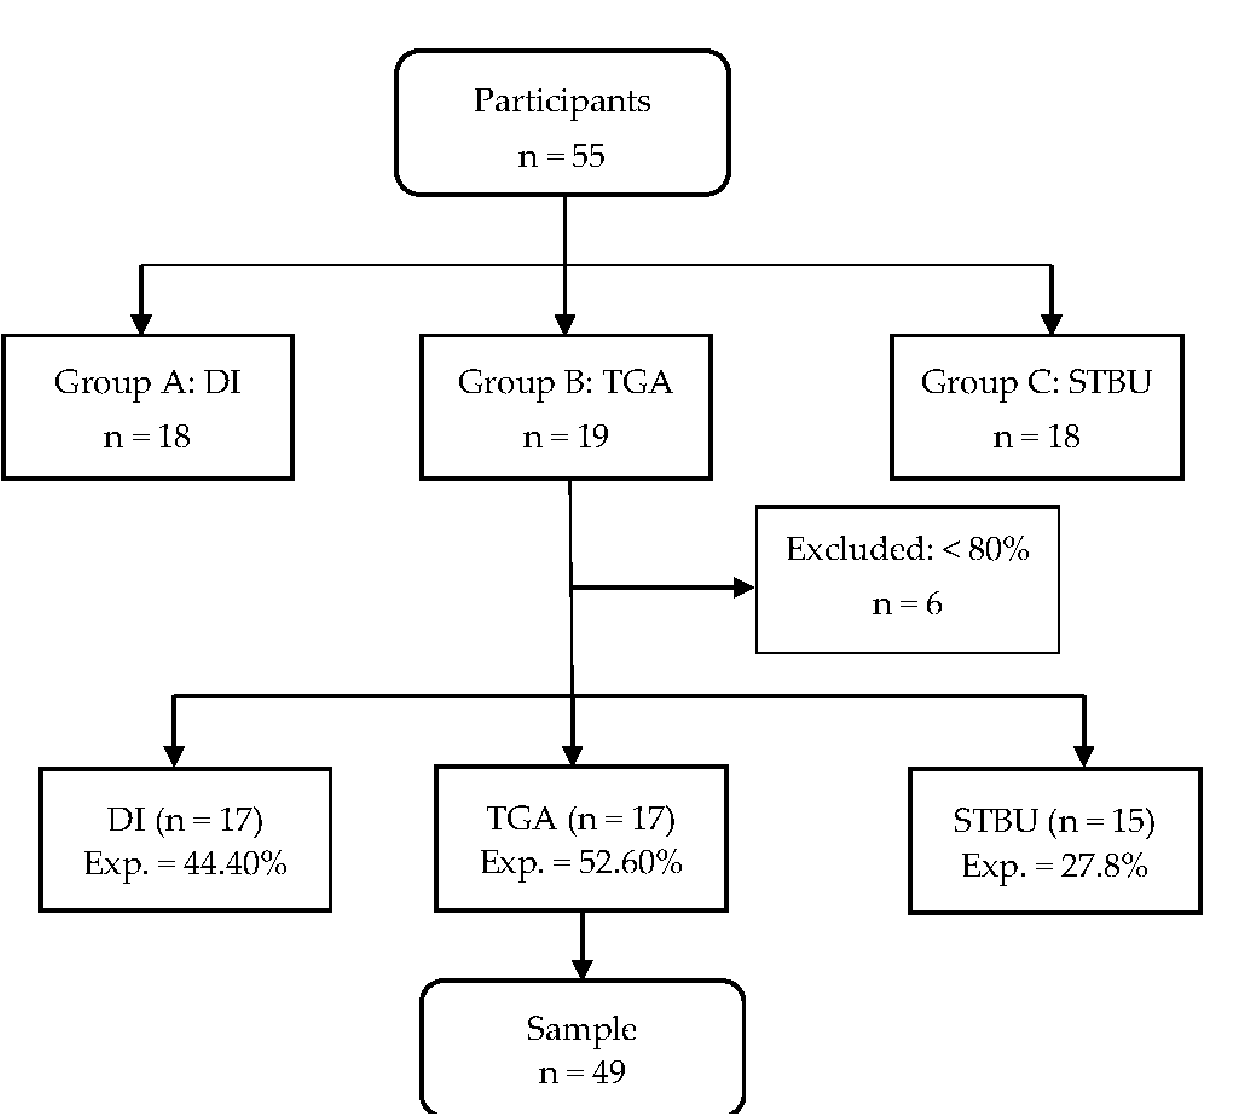
Figure 1. Flow chart. Note: Exp., previous experience in basketball; n, number.